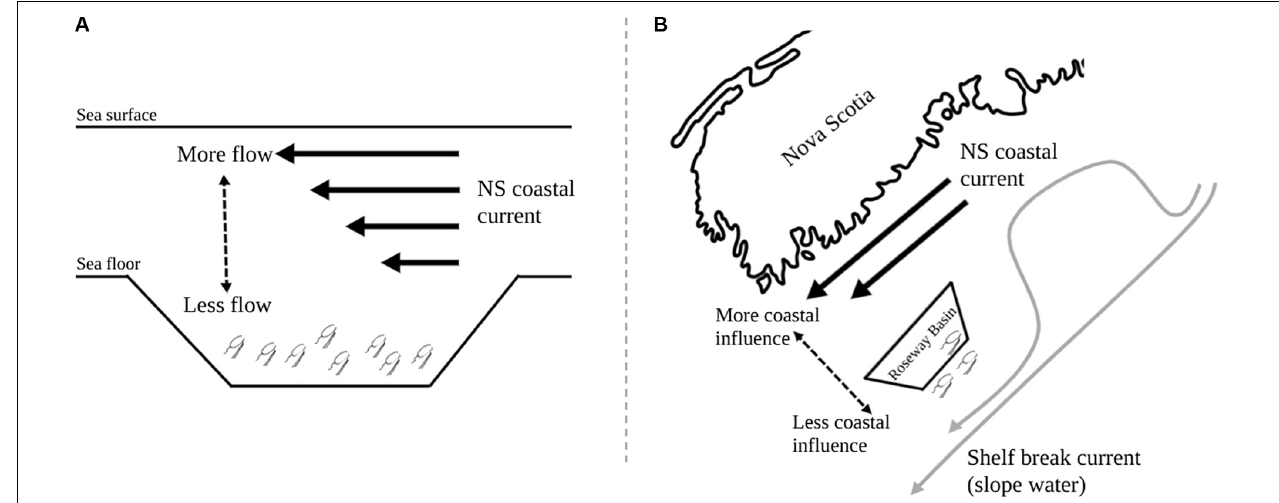
FIGURE 8 | Conceptual diagram of the NS coastal current over Roseway Basin showing (A) the vertical gradient in current strength where stronger flow is in surface waters, and (B) the horizontal gradient in current strength where stronger flow occurs closer to